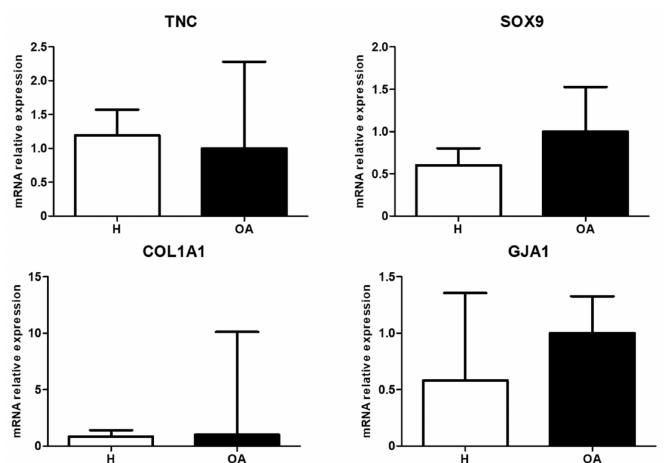
Figure 6. mRNA relative expression of TNC, SOX9, COL1A1, and GJA1 from H-(white) and OA-(black) derived BM-MSCs pellets, after three days, under CM. Values are given as the mean of three donors with standard deviation.